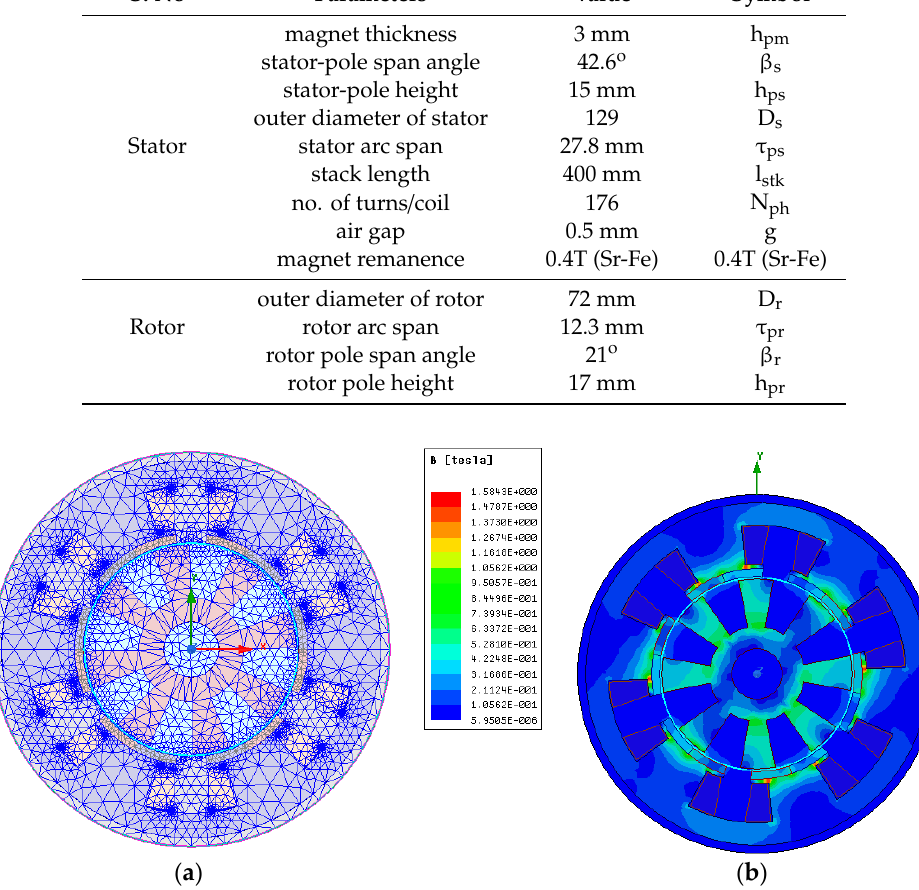
Figure 20. FEA evaluation of no-load behavior of FRM: ( a ) mesh plot; ( b ) flux density map. Table 2. Dimensional details of non-rare-earth (NRE) FRM.